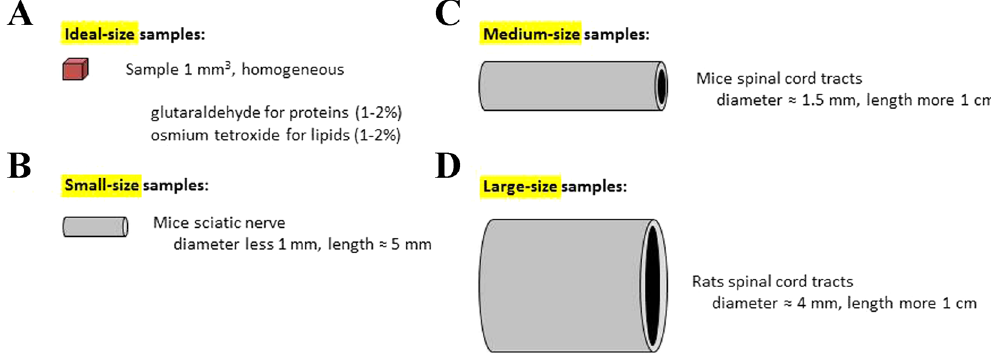
Figure 1. Sample sizes classification. ( A ) Ideal-size sample - cellular pellet; ( B ) small-size sample - mice sciatic nerves; ( C ) medium-size sample - mice spinal cord tracts; ( D ) large-size sample - rat spinal cord tracts. The sizes reported in the figure are proportional to the real dimensions of the